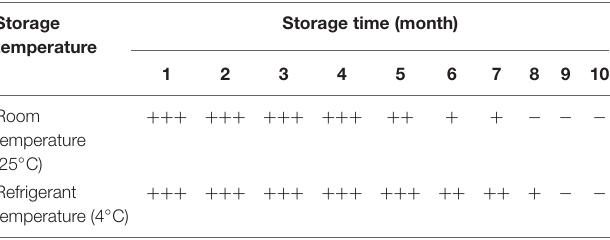
TABLE 2 | Stability experiment results from ICS.